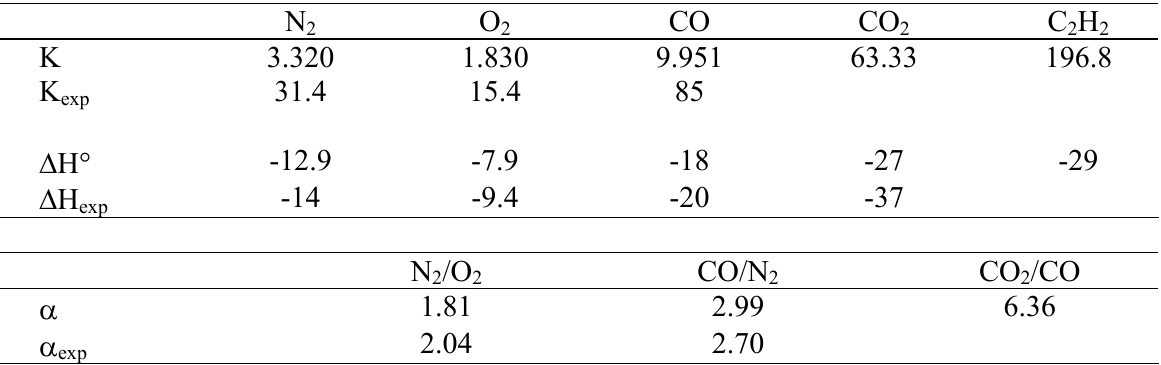
Table 3: Henry constants, separation constants and isosteric heats of adsorption on NaY : comparison between theory and experiment [94][98]. O N 2